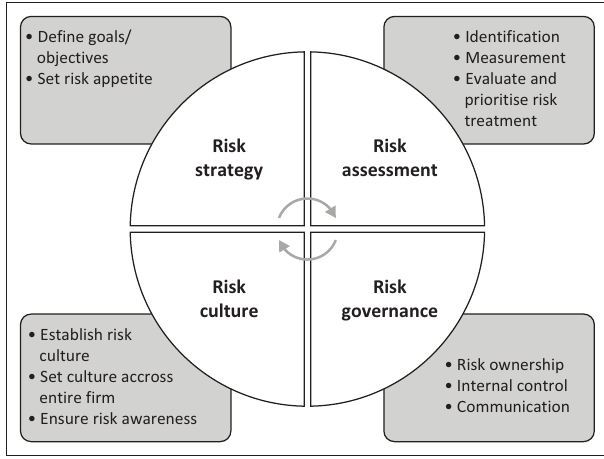
FIGURE 1: Reputational risk management